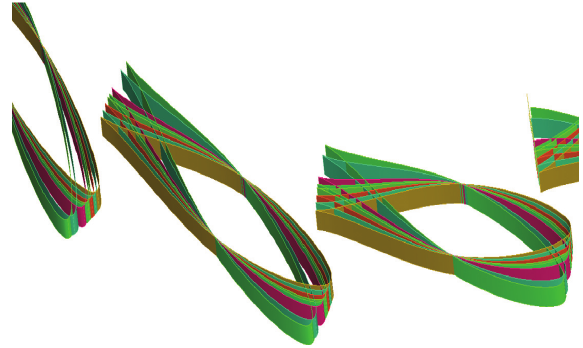
Figure 9: Variable nozzle ring. Table 2: Different grid number numerical simulation results.